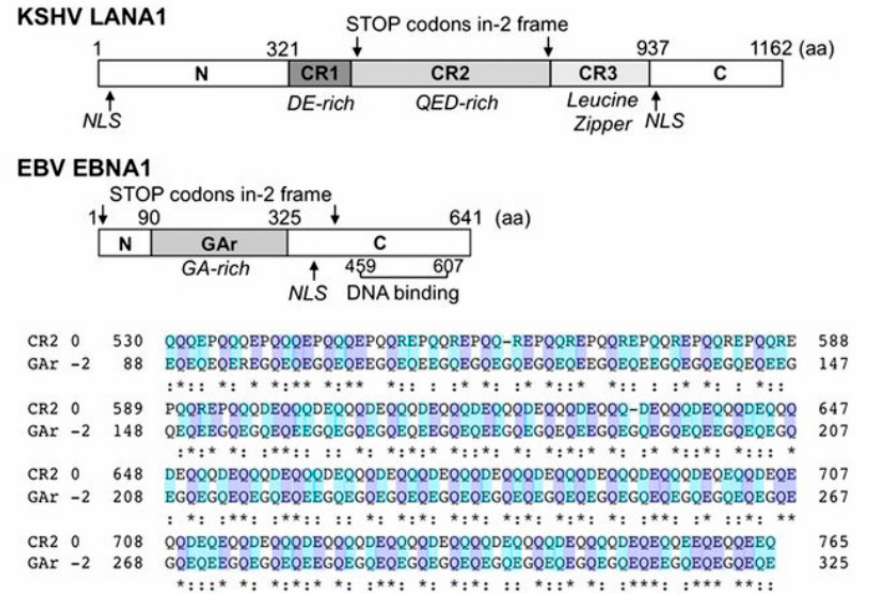
Figure 7. Map of KSHV LANA1 and EBV EBNA1 and amino acid sequence alignment comparing LANA1.CR2 and EBNA1.GAr in the − 2 frame (EBNA1ARF). EBNA1 comprises the N terminus, GA-rich central domain, and C-terminal DNA binding domain. Stop codons of the − 2 frame are indicated with arrows. Although the EBNA1 GAr (0 frame) has no amino acid similarity to the LANA1 CR, EBNA1ARF has ∼ 35% similarity to the 0 frame of the LANA1 CR2 domain, and both sequences contain highly acidic QE ‐ rich repeats. From Ref. [5].